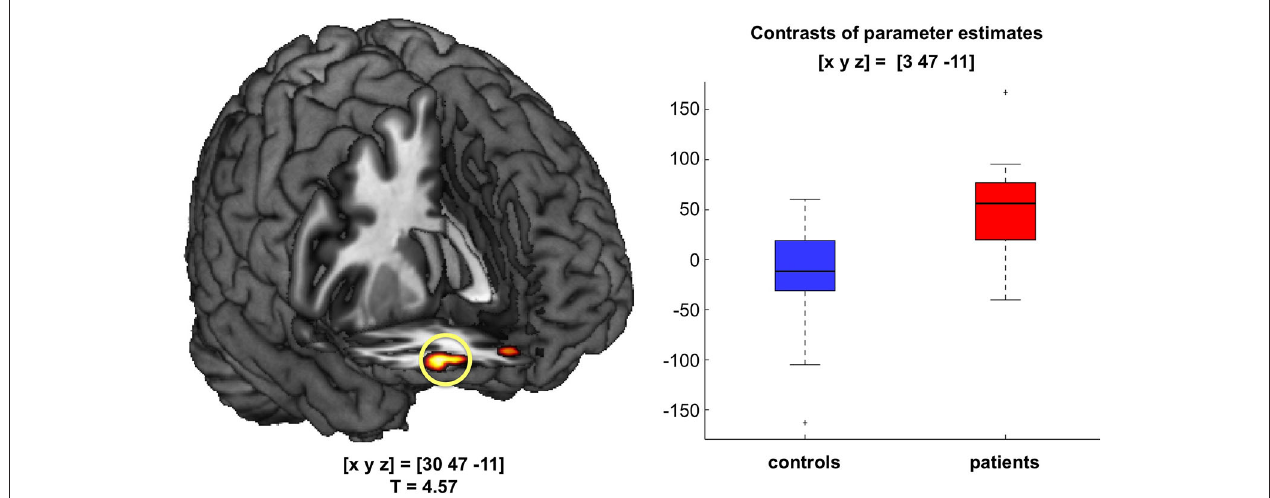
FWE-corrected for a combined anatomical and literature-based ROI of the OFC). Bar plots depict contrasts of parameter estimates at peak voxels +/ − standard